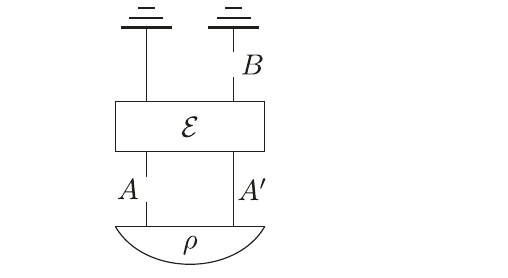
Fig. 1 Simple circuit with two quantum nodes A and B . For any state ρ and any CPTP map E this de fi nes a process operator over A and